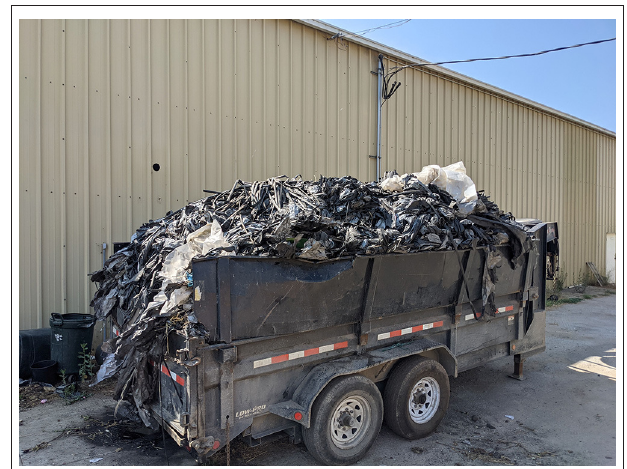
FIGURE 3 | Polyethylene mulch removed at the end of the growing cycle (photo by Brenda